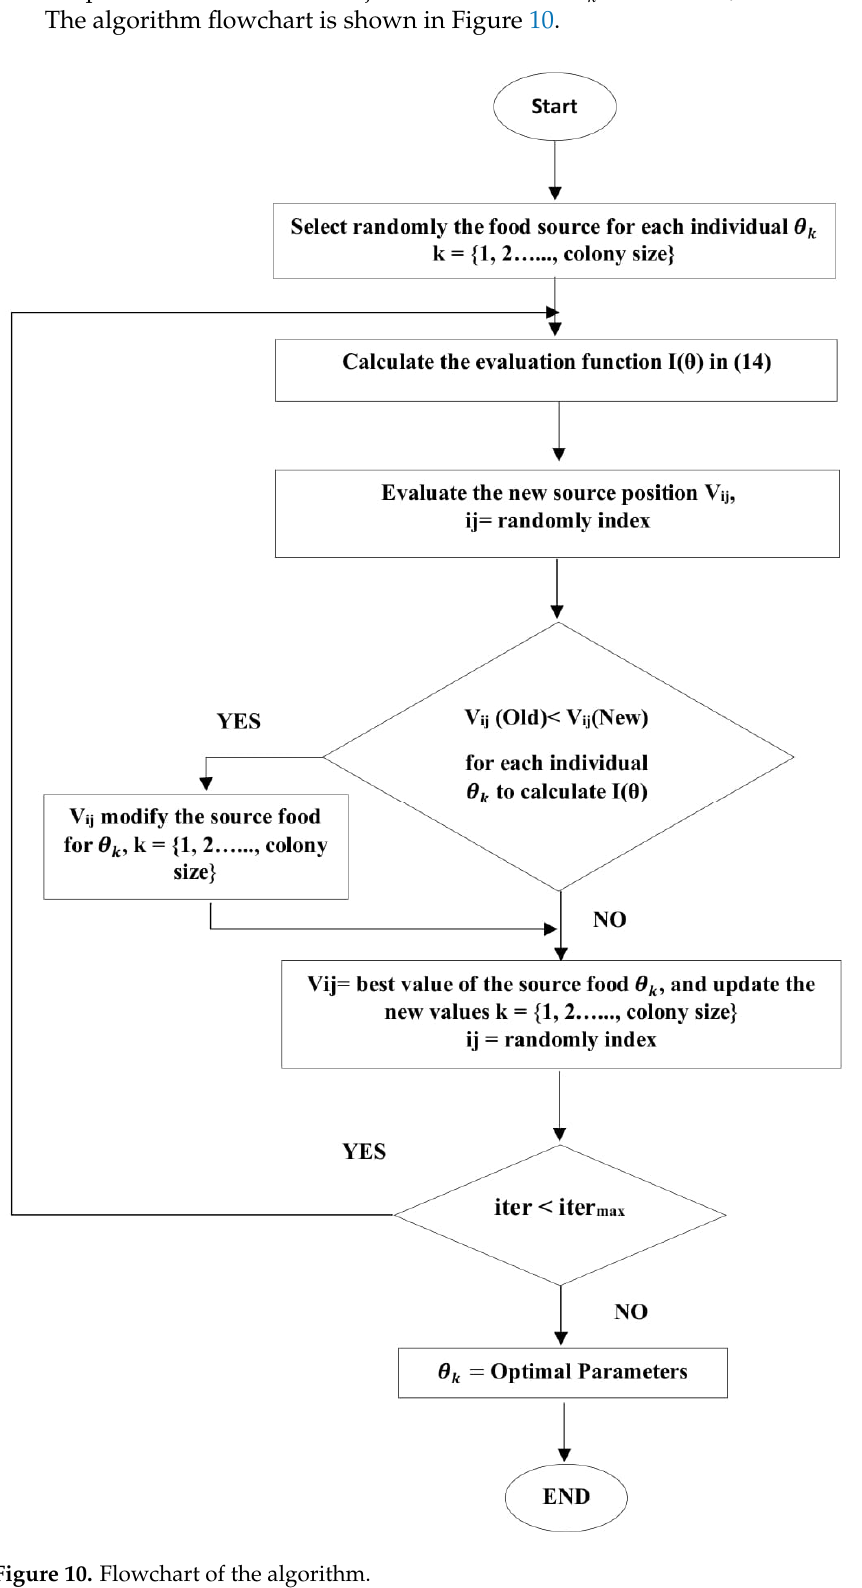
Figure 10. Flowchart of the algorithm.